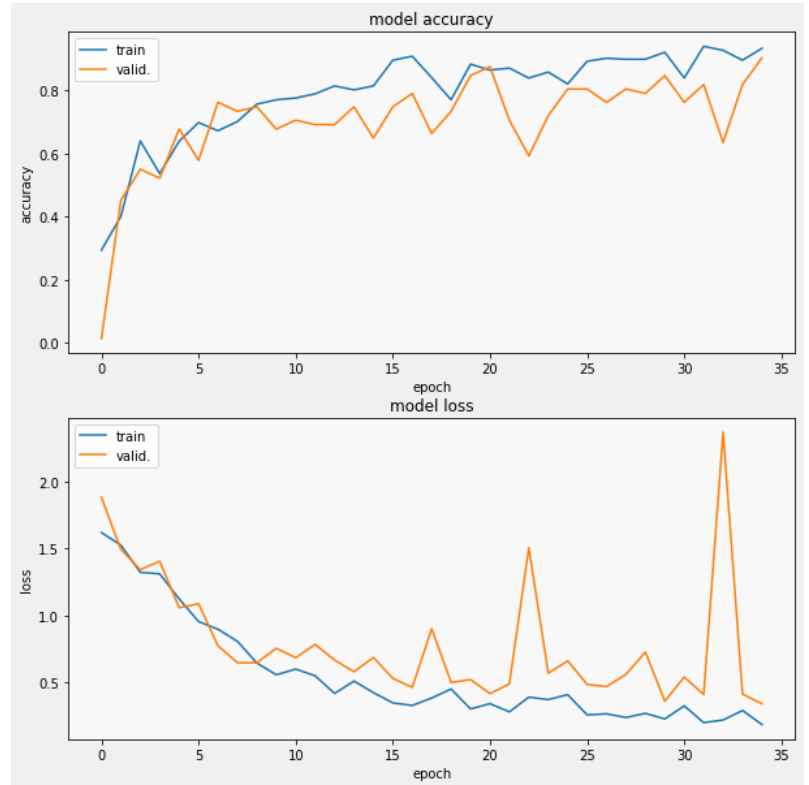
Figure 11. Validation loss and model accuracy by epoch during the training process.